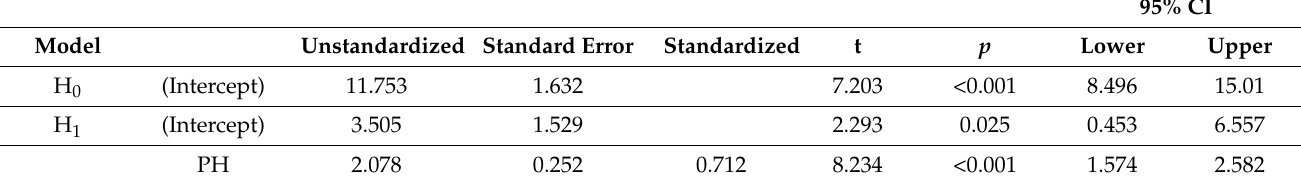
Table 11. Wet candle method and horizontal dry plate method—coefficient of linear regression analysis.